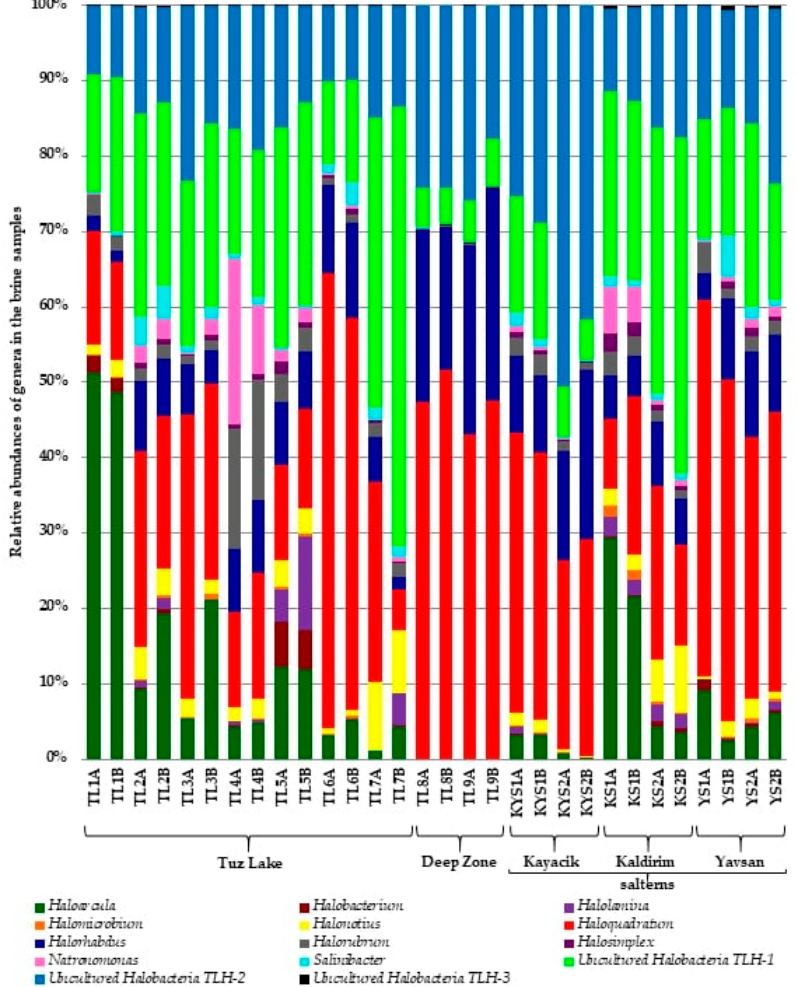
Figure 3. Taxonomic profiles at the genus level of prokaryotic communities detected in brine samples of Tuz Lake (TL1A to TL7B), Deep Zone (TL8A to TL9B), and Kayacik (KYS1A to KYS2B), Kaldirim (KS1A to KS2B), and Yavsan (YS1A to YS2B) salterns. Each OTU contains at least 1% 16S rRNA sequence. Table 2. Taxonomic distribution at the genus level, with more than 0.3% sequences detected in the brine samples collected from Tuz Lake, Deep Zone, and Kayacik, Kaldirim, and Yavsan salterns. Genus/Taxon